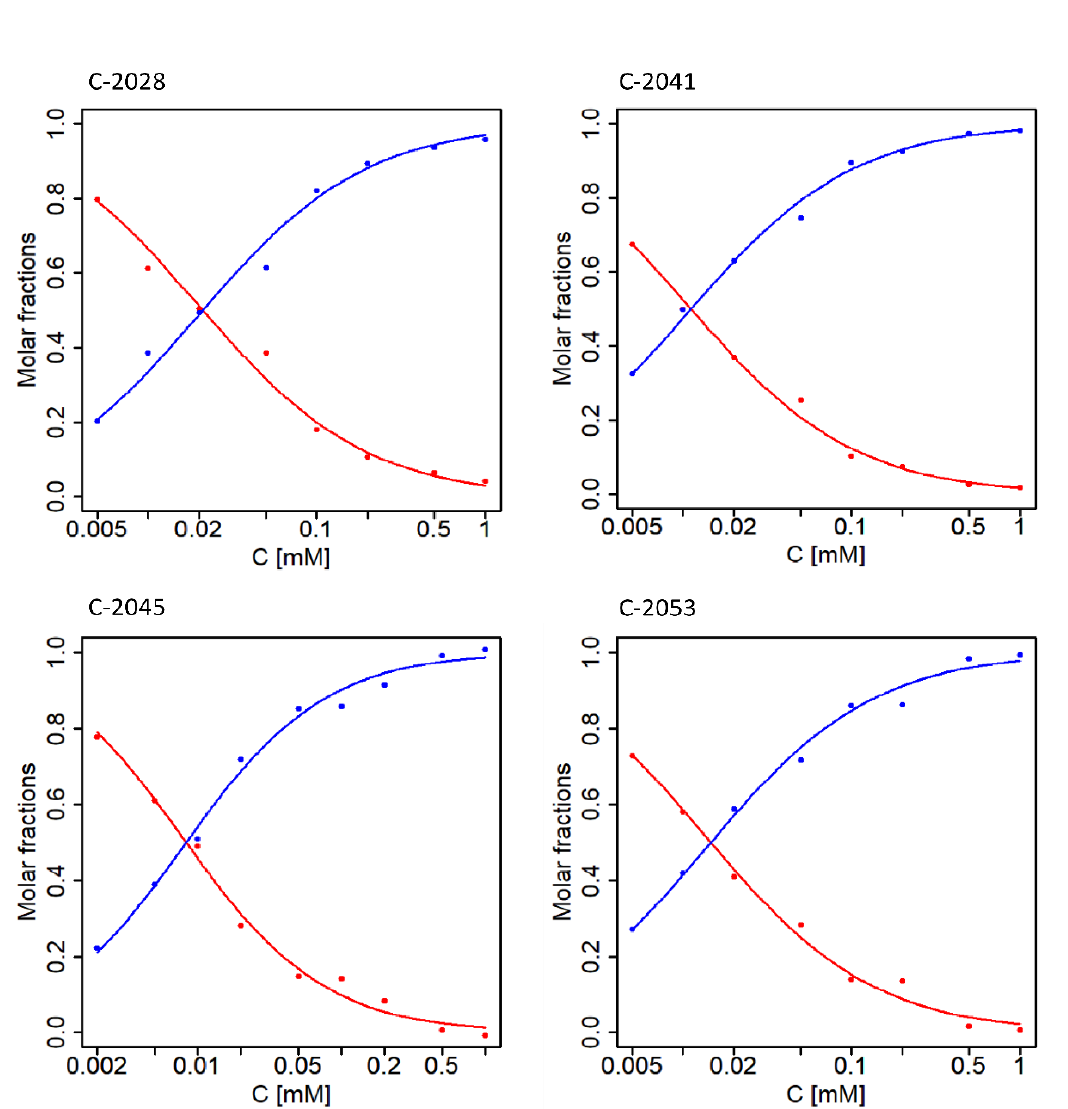
Figure 7. Molar fractions for UAs studied at pH = 3.5 and 35 ◦ C. Points—optimal molar fractions; curves—the best fit of the theoretical model of dimerization to the data. Red color—monomer, blue